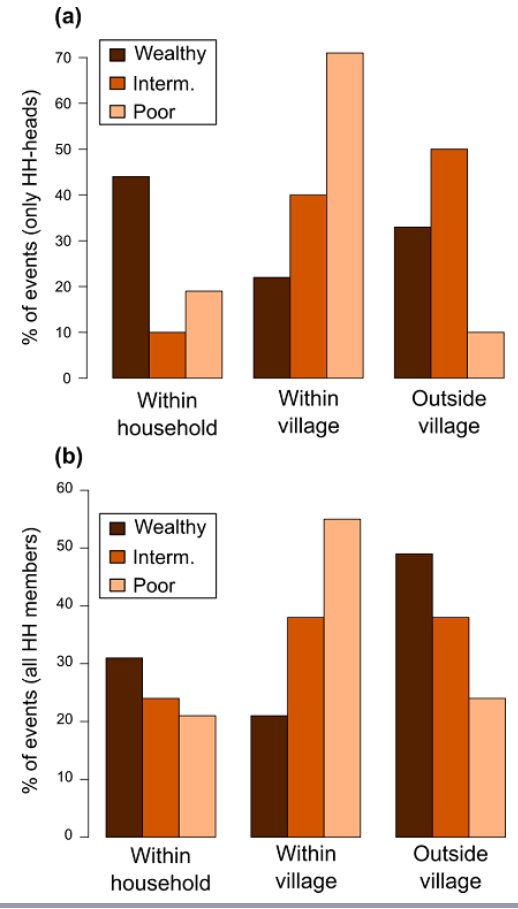
Fig. 2. Number of seed acquisition events based on household (HH) socioeconomic status and seed source. (a) Household heads (Fisher’s exact test, P = 0.009). (b) All household members (Pearson’s chi-square test, P =